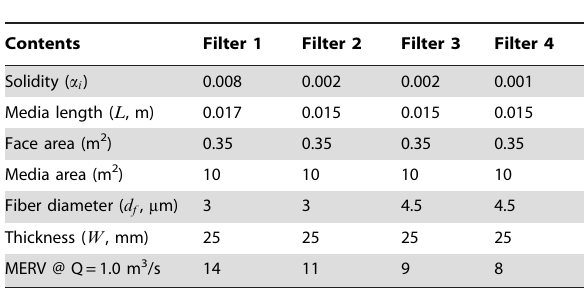
Table 2. Specifications of model